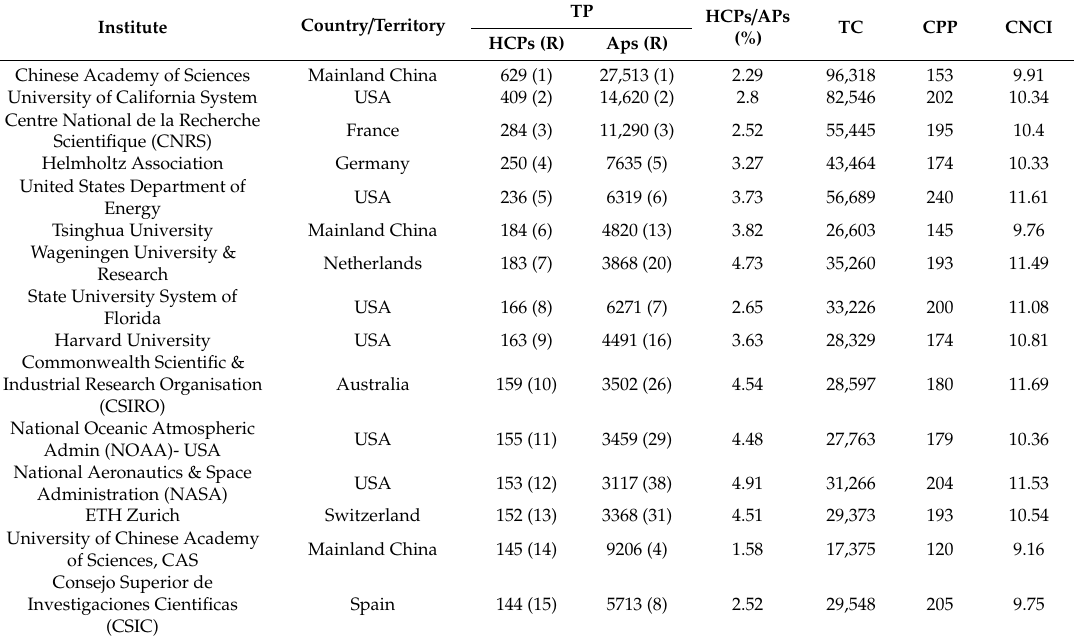
Table 3. Characteristics of the top 15 productive